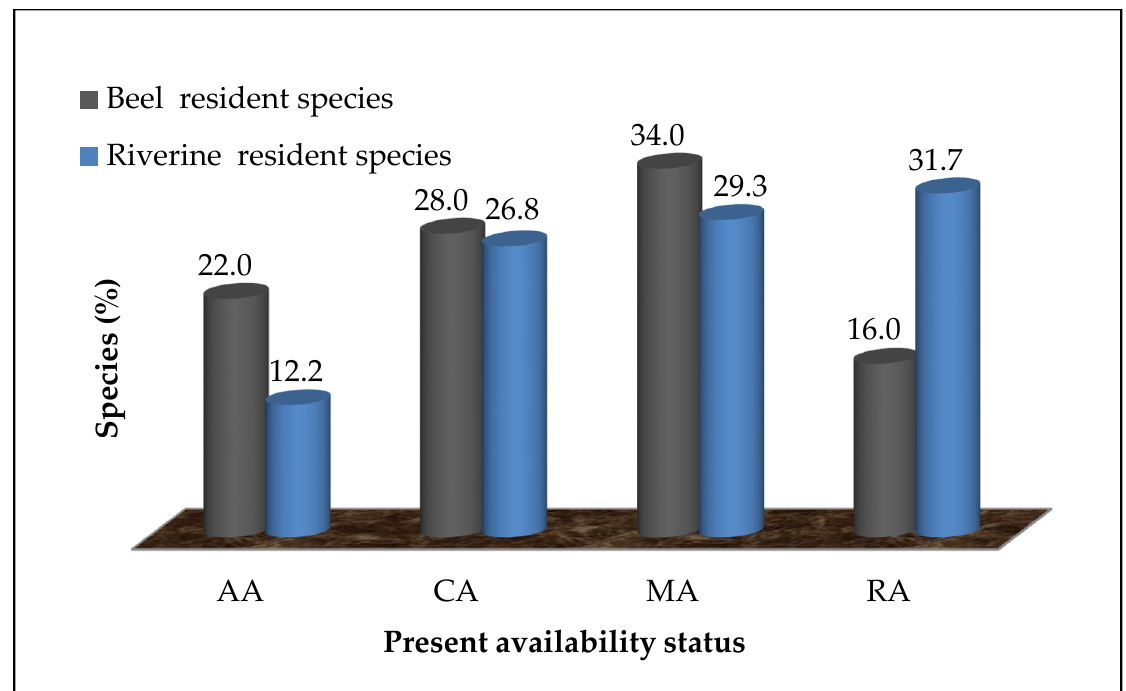
Figure 6. Present availability status of beel and riverine resident species.